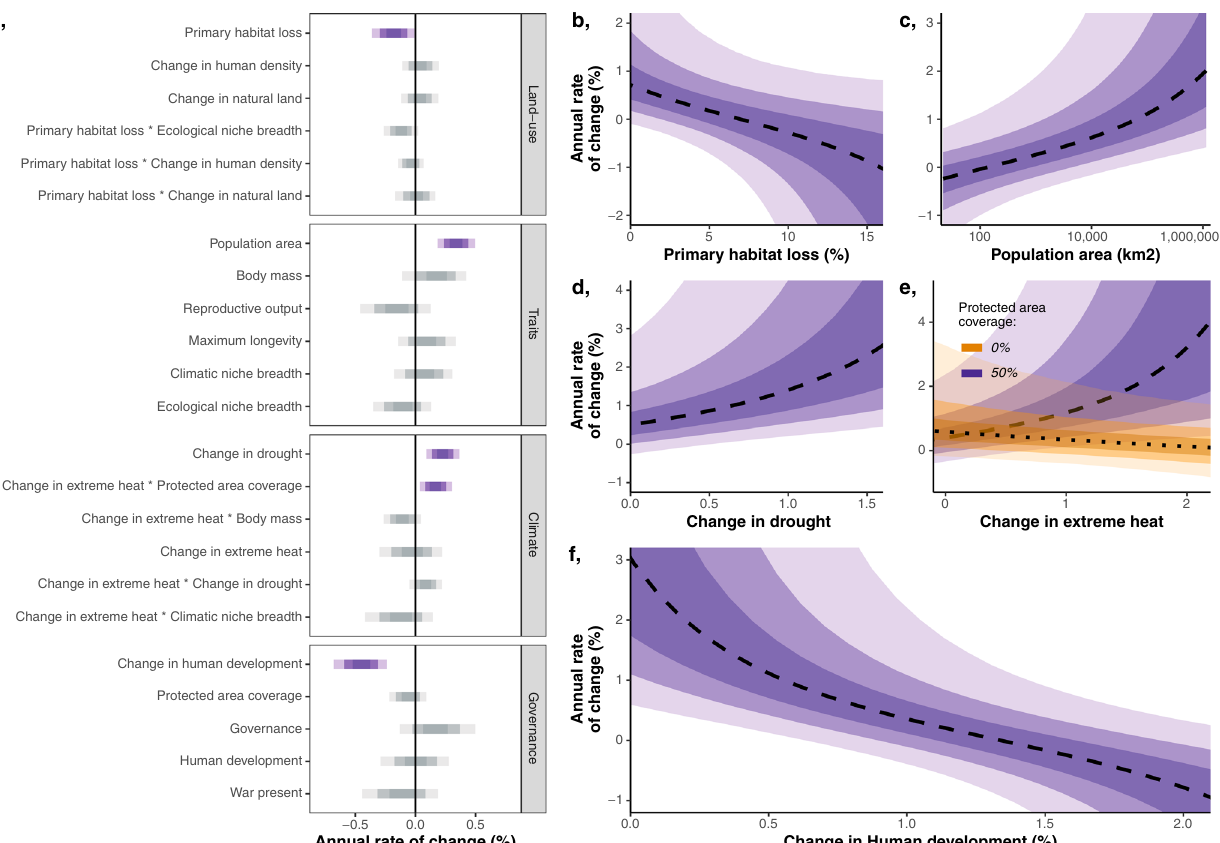
Fig. 3 | Multiple drivers ofpopulation changein large carnivores.a Annual rate ofchangecoef fi cientsfrom fi xedeffectparametersinahierarchicalBayesianlinear model, with 50%,80%,and 95%credible intervals. Coef fi cients with aneffectatthe 95% credible interval are coloured in purple. Parameters are ordered by effect size withinrespectivefacets. b – f Marginaleffectsforaselectionofimportantcovariates against median predicted annual rate of change: mean annual primary habitat loss ( b ); area of population buffer zone on the log 10 scale ( c ); mean number of months peryearwheretheaveragedegreeofdroughtinthepopulationmonitoringperiod